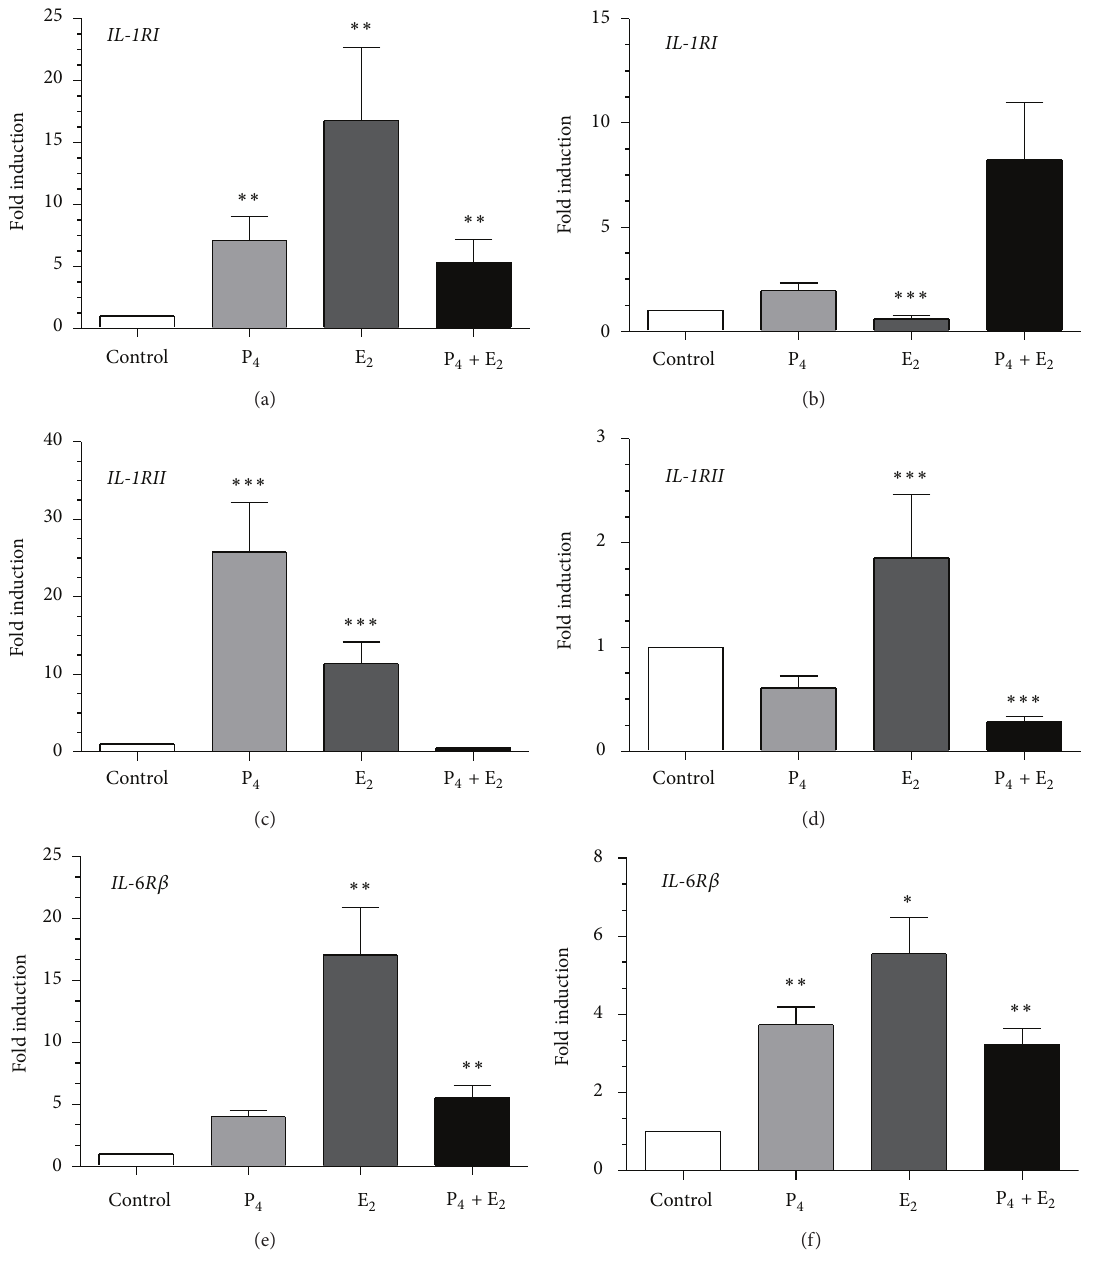
Figure 6: The effect of P 4 (10 −7 M), E 2 (10 −9 M), and P 4 + E 2 (10 −7 /10 −9 M) on IL-1RI ((a), (b)), IL-1RII ((c), (d)), and IL-6R 𝛽 ((e), (f)) mRNA transcription in epithelial cells ( 𝑛 = 5 ) and stromal cells ( 𝑛 = 5 ) after 24 h incubation. Results are normalized against ACTB. Data are presented as fold induction relative to control. Asterisks indicate significant differences ( ∗ 𝑃 < 0.05 ; ∗∗ 𝑃 < 0.01 ; ∗∗∗ 𝑃 < 0.001 ) from the respective control, as determined by nonparametric one-way ANOVA Kruskala - Wallisa followed by Dunns’a test